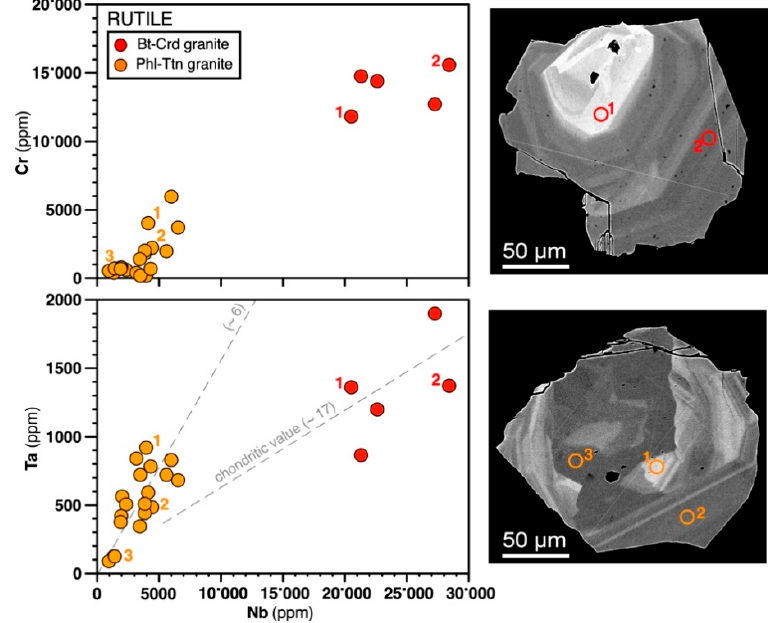
Figure 9. Compositional diagrams which show the mineral chemistry of metasomatic rutile crystallized in the granite during incipient metasomatism of the ilmenite and titanite in the biotite-cordierite granite (red) and in the phlogopite-titanite granite (orange). The diagrams show the tendency of Ta to decouple from Nb (chondritic Ta / Nb = 17.6, [26]). On the right, back-scattered electron images show the strong, complex zoning observed in rutile crystals.